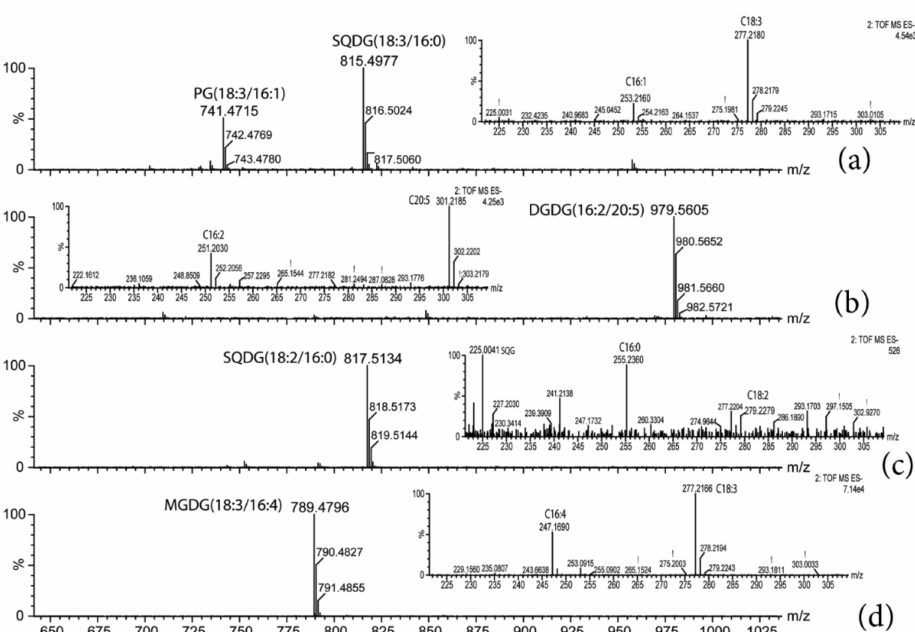
Figure 2. Mass spectra obtained in low energy function (full-scan) and in high energy function 2 (MSE; figure insert) of some relevant glycerolipid species. The [M-H]- ions of the fatty acyls esterifying the corresponding glycerolipid species shown in the full-scan are pointed out in the inserted figure. ( a ) diacylglycerylphosphoglycerol (PG), ( b ) digalactosyldiacylglycerol (DGDG), ( c ) sulfoquinovosyldiacylglycerol (SQDG), and ( d ) monogalactosyldiacylglycerol (MGDG). Under high light (c.a. 45 µ mol photons m − 2 s − 1 ), the relative content of MGDG in